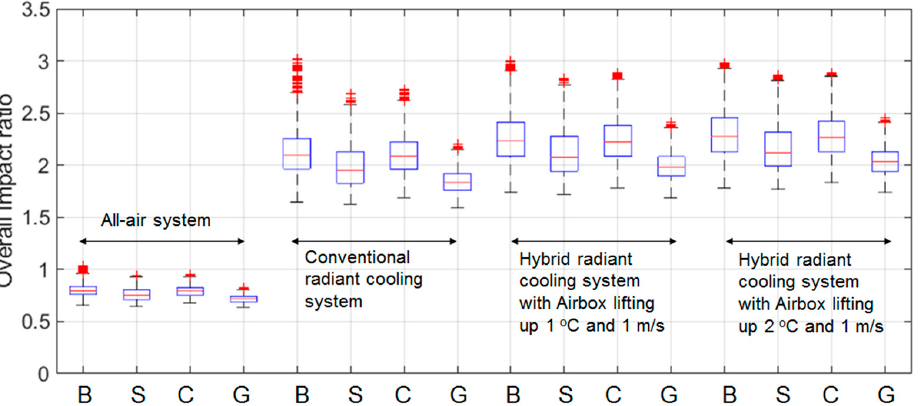
Figure 10. Overall impact ratio of the three cooling systems in four cities: B—Beijing, S—Shanghai, C—Chengdu, and G—Guangzhou .